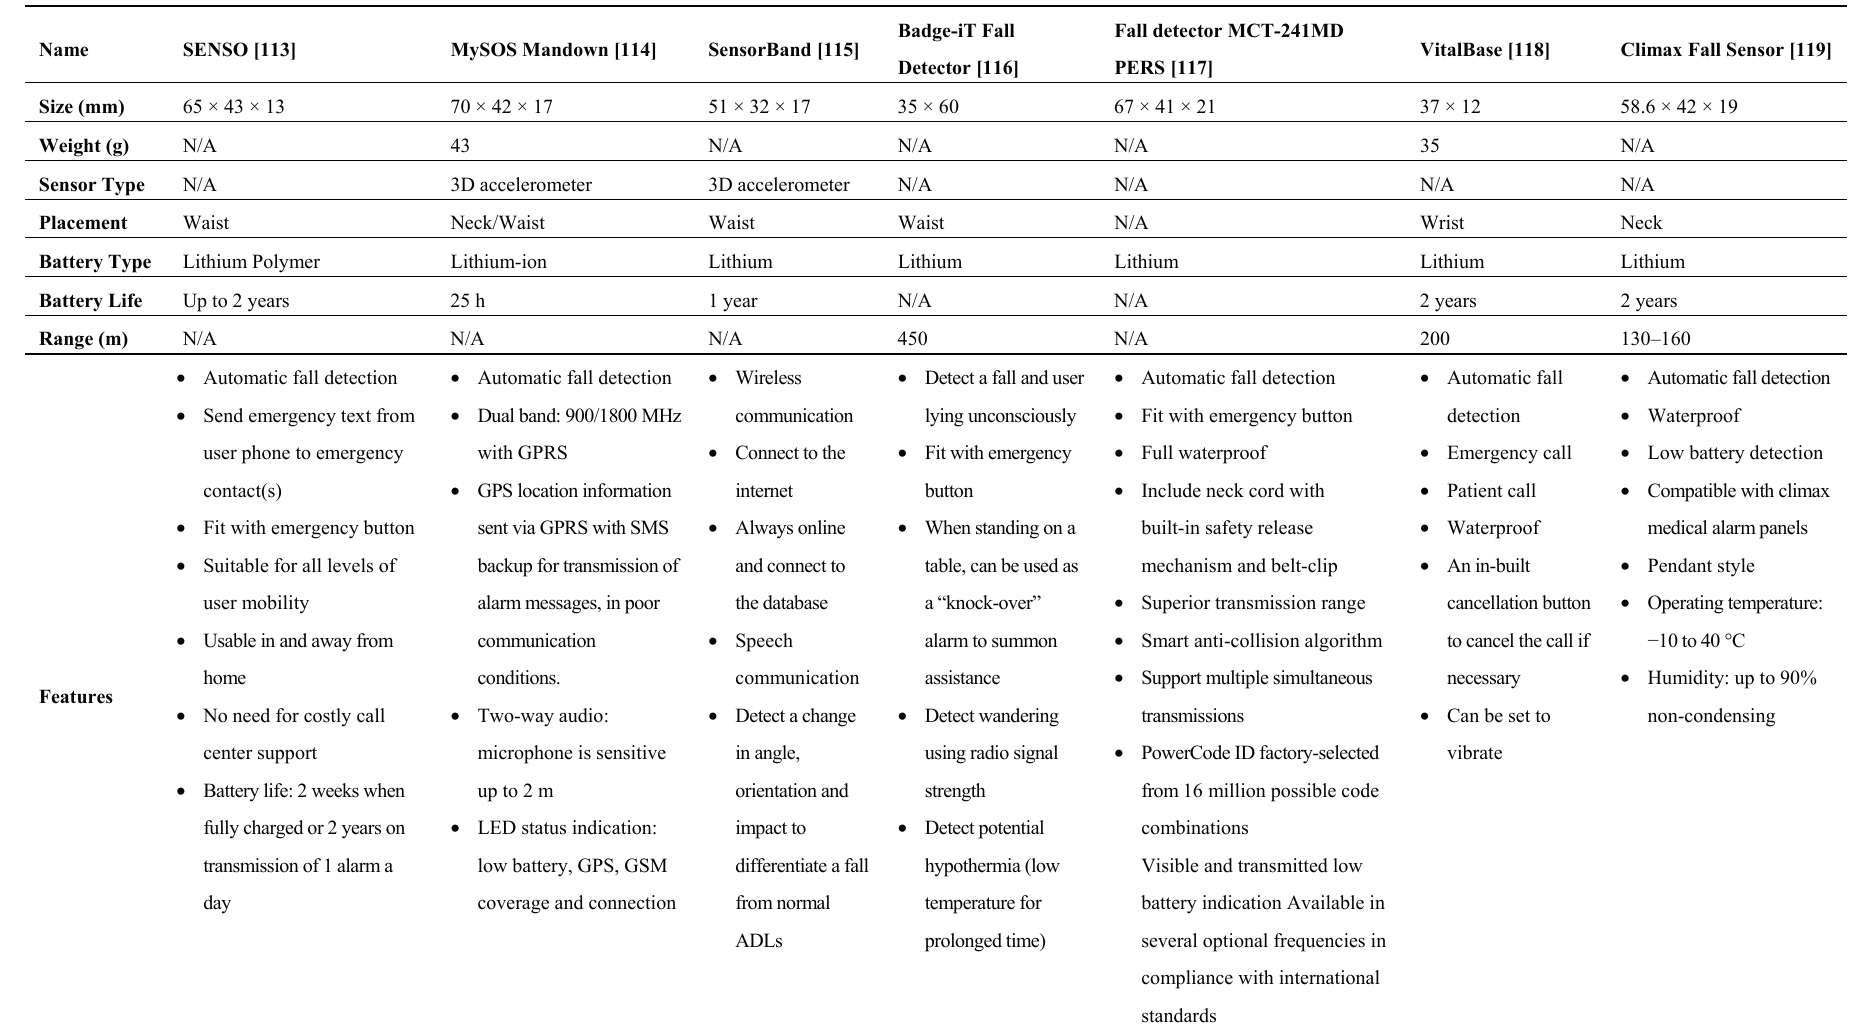
Table 6. Wearable fall detection